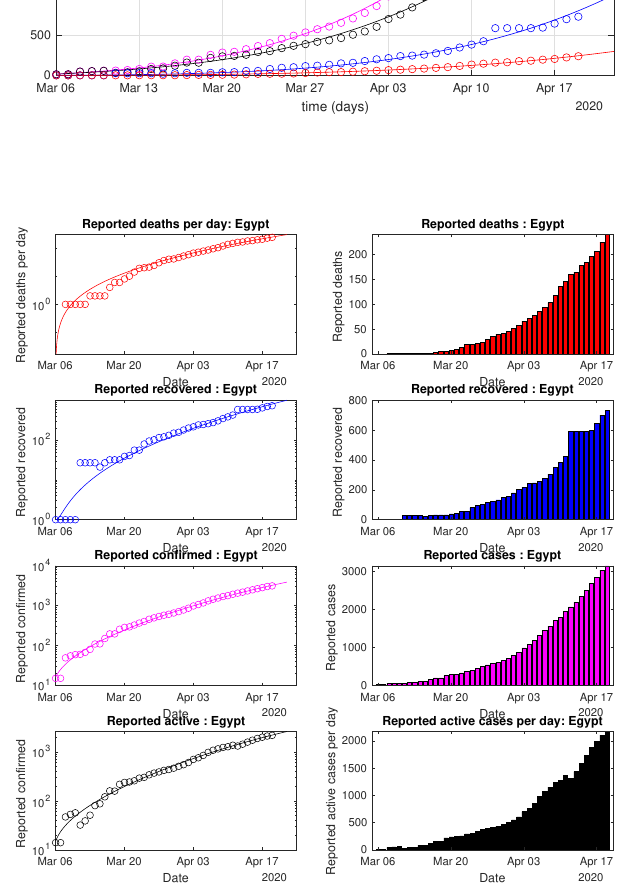
Figure 59. Egypt: data vs.